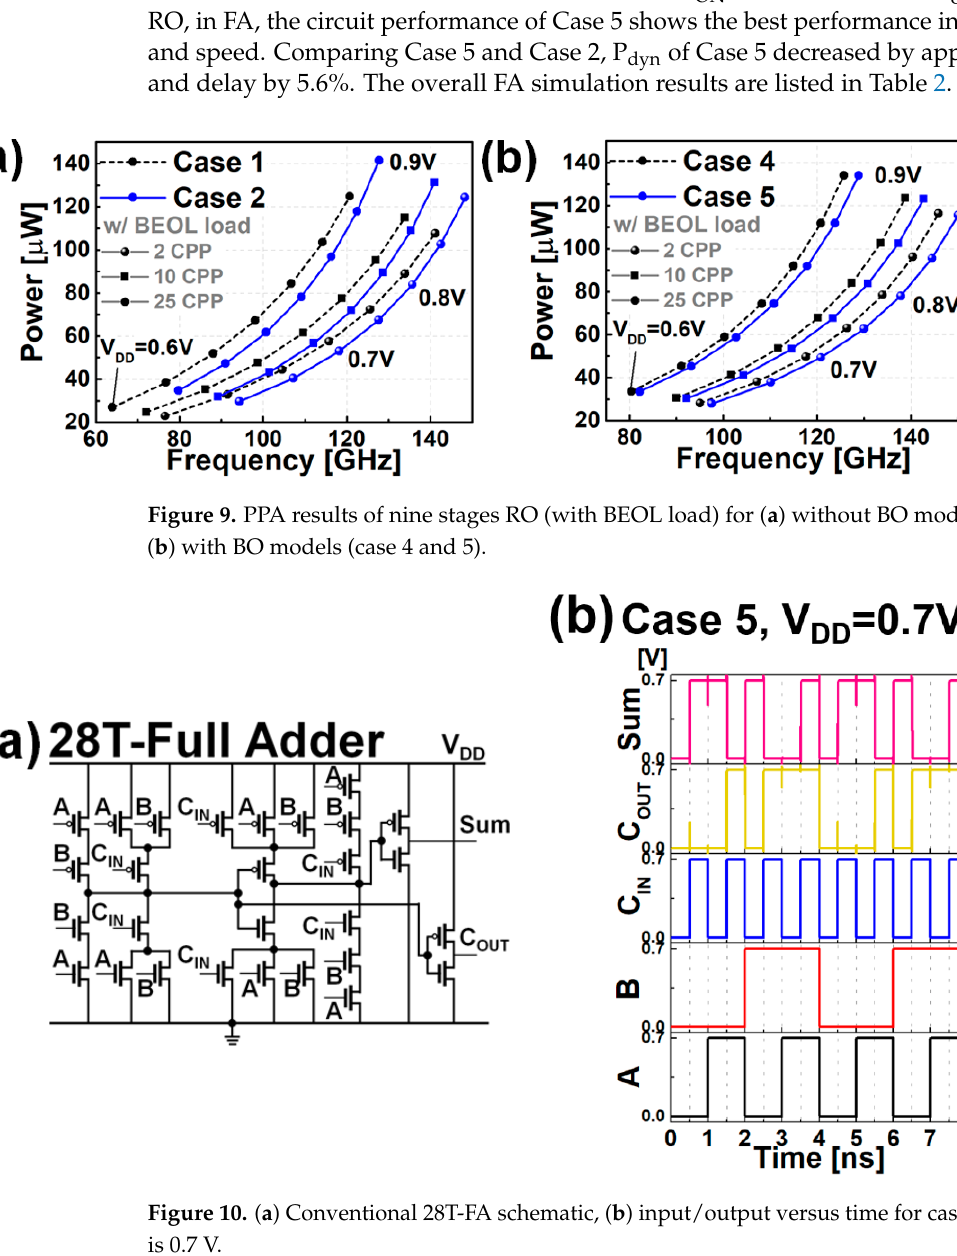
Figure 9. PPA results of nine stages RO (with BEOL load) for ( a ) without BO models (case 1 and 2), ( b ) with BO models (case 4 and 5).